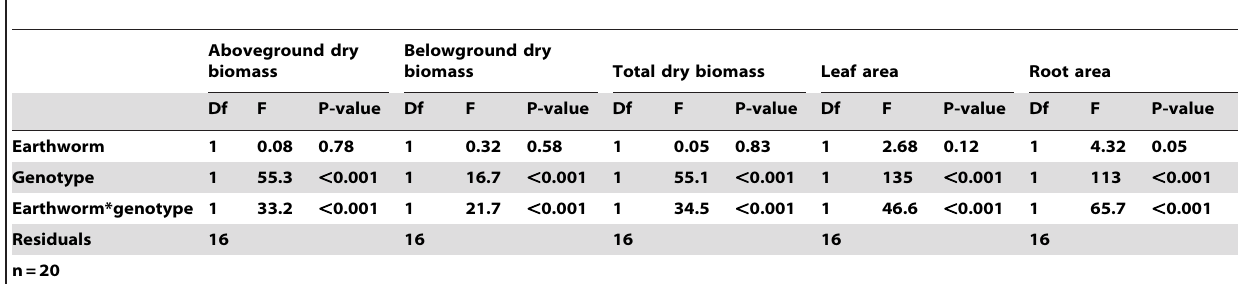
Table 1. Impact of the factor ‘‘earthworm’’ and ‘‘genotype’’ on biomass and morphological parameters of Arabidopsis thaliana , estimated in a two-ways ANOVA.